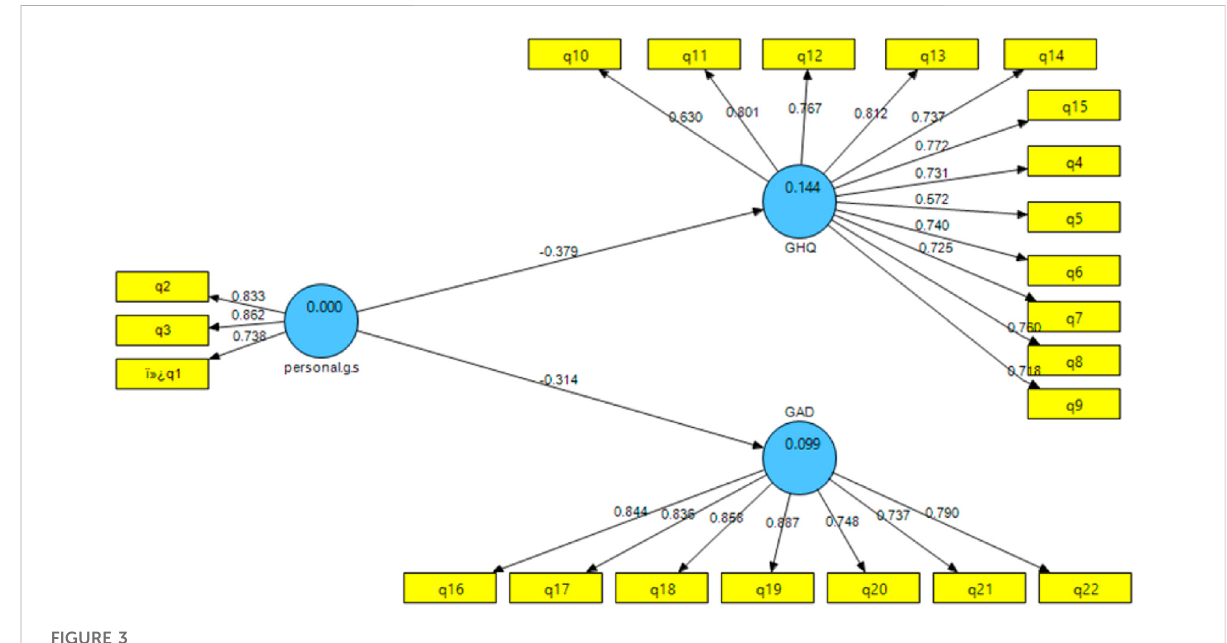
FIGURE 3 Standard path coef fi cient of the structural model.